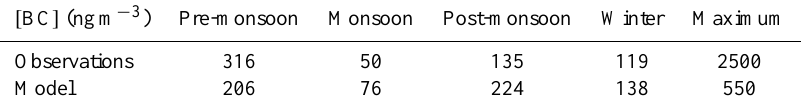
Table 1. Summary of atmospheric concentrations of BC observed at the Nepal Climate Observatory-Pyramid (NCO-P, 27.95 ◦ N, 86.82 ◦ E, the model is located at 4480ma.s.l. and seasons are defined as in Table 1 of Bonasoni et al.